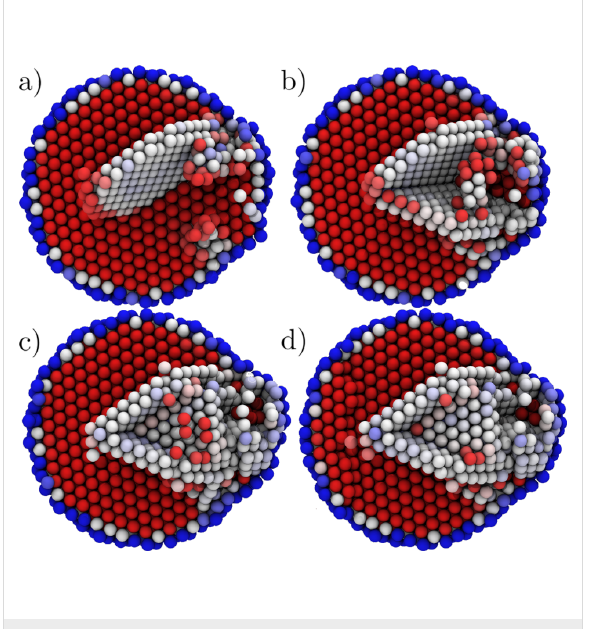
Figure 4: Extrusion from 15 Å orifice. (a) The nucleation of the first Shockley partial. (b) Two nonlocking sessile Shockley partials. (c) A stair rod is formed. (d) The dislocations are pinned to the particle surface through a <312> dislocation.